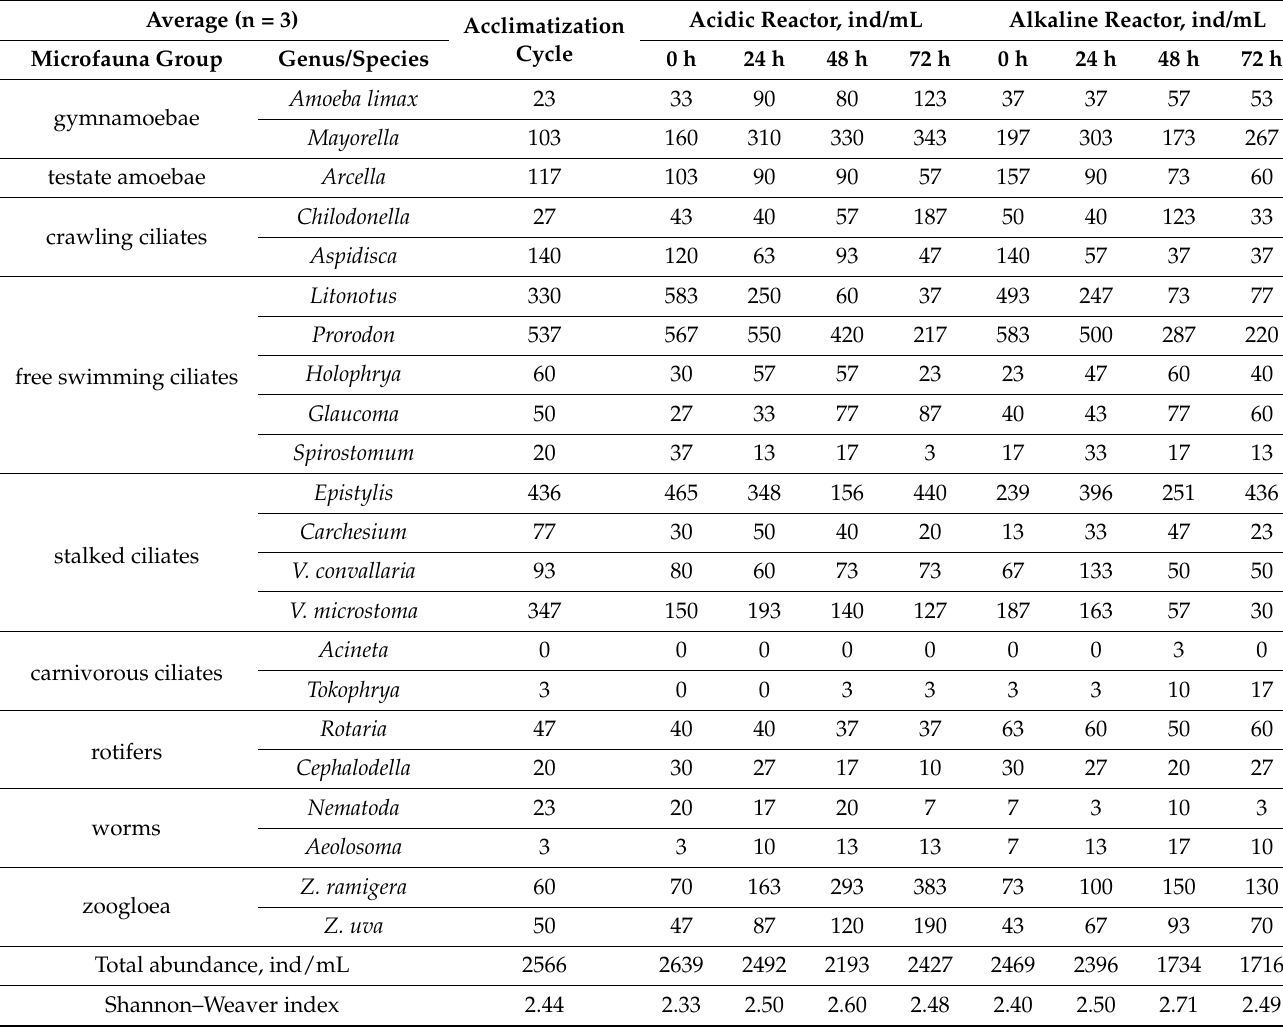
Table 2. Microfauna changes (n = 3) in the acidic and alkaline